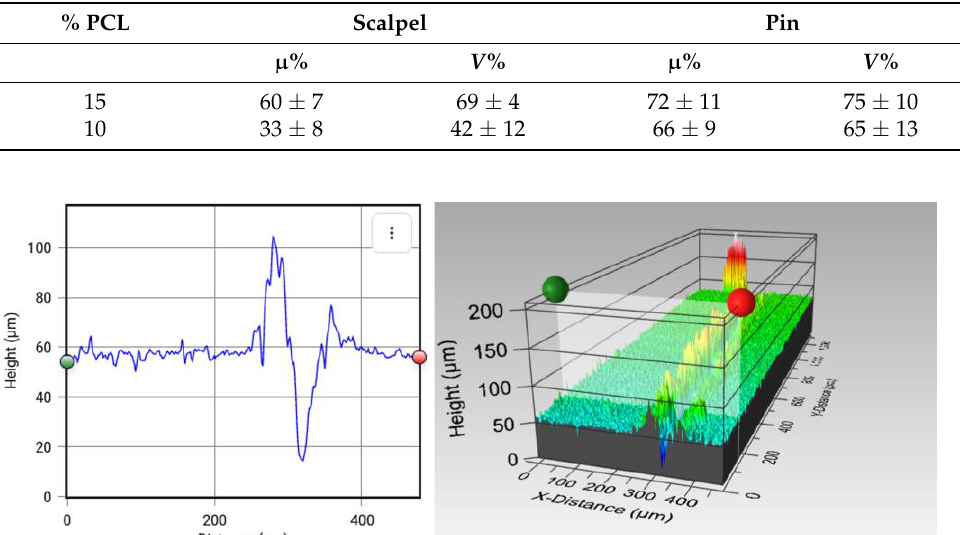
Table 3. Results of the self-healing efficiencies of samples damaged with the scalpel and the pin after heating at 150 ◦ C.